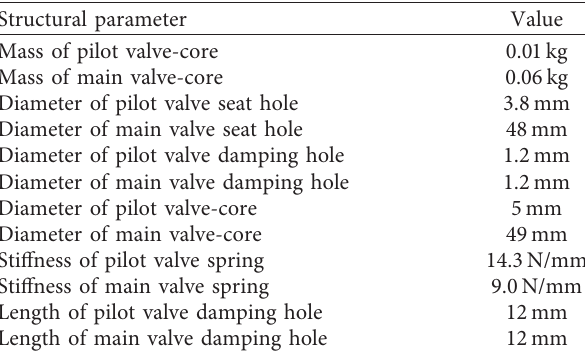
Table 2: Initial structural parameters of relief